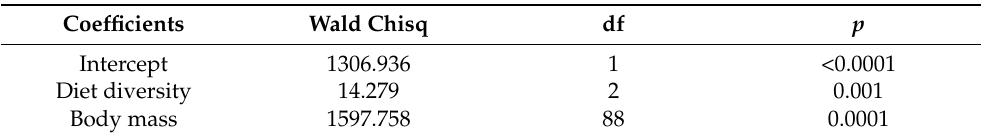
Table 1. Results of a GLM (Generalized Linear Models) analysis testing whether microbial diversity depends on diet and body mass in F.